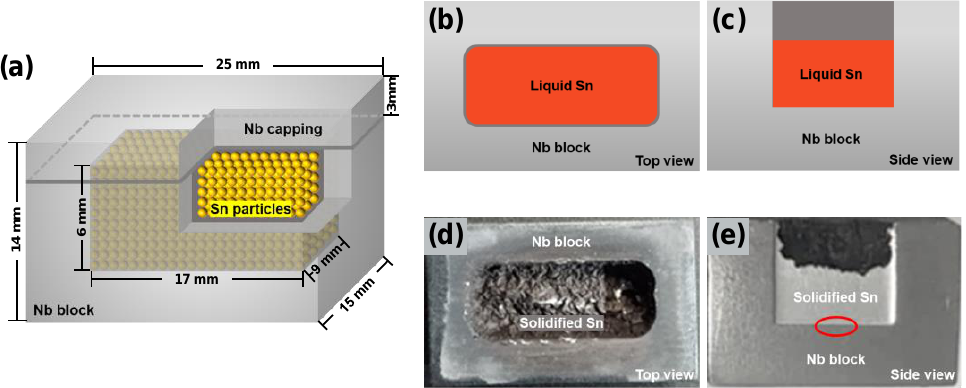
Figure 1. Geometry of Nb/Sn LSDC: ( a ) Schematic diagram for the assembled Nb/Sn LSDC; ( b ) top view and ( c ) side view of Nb/Sn LSDC during the heat treatment. Typical photos of physical sample for the Nb/Sn LSDC after annealing at 1200 °C for 2 h: ( d ) top view and ( e ) side view.